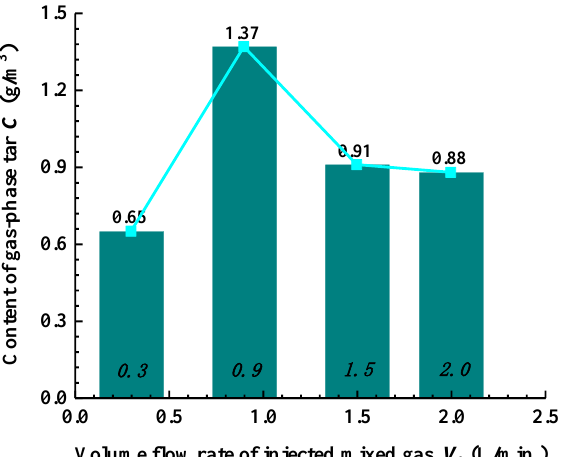
Figure 7. Influence of volume flow rate of injected mixed gas on the absorption efficiency of gas- phase tar.